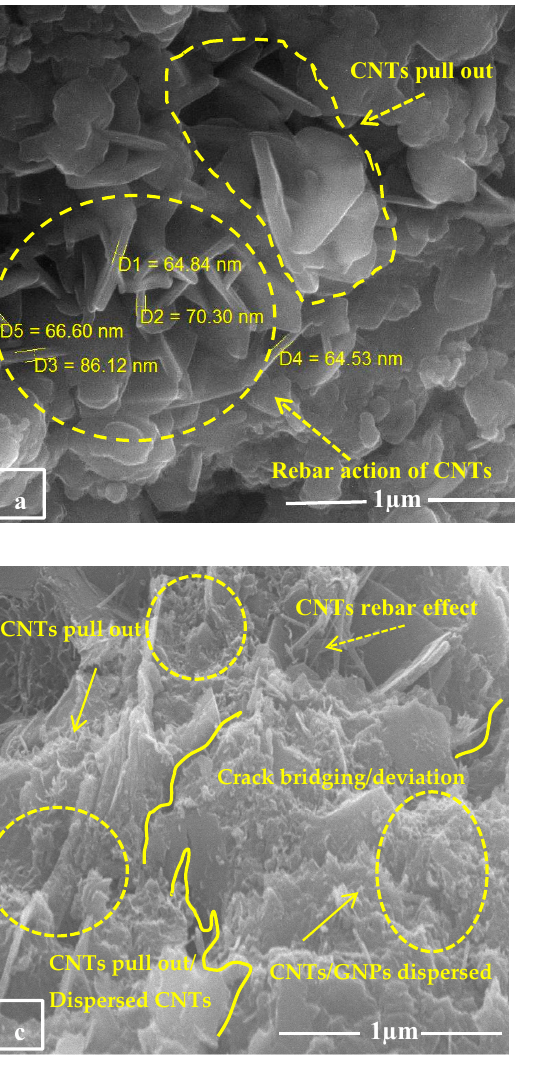
Figure 18. ( a , b ) Rebar and pull out effect of CNTs, ( c ) crack deviation and pull out of CNTs, ( d ) crack discontinuity and presence of dense calcium silicate gel with AFT.